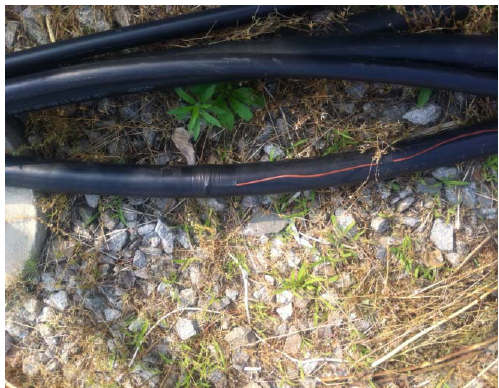
Figure 13. Installation of temperature sensor in